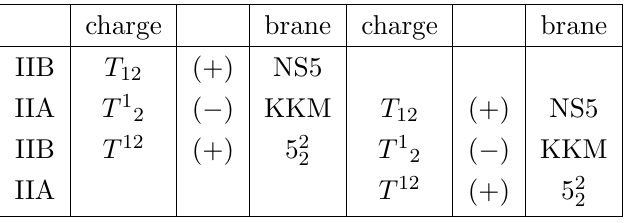
Table 1 . Branes and their charges. Note that T 2 1 would also describe